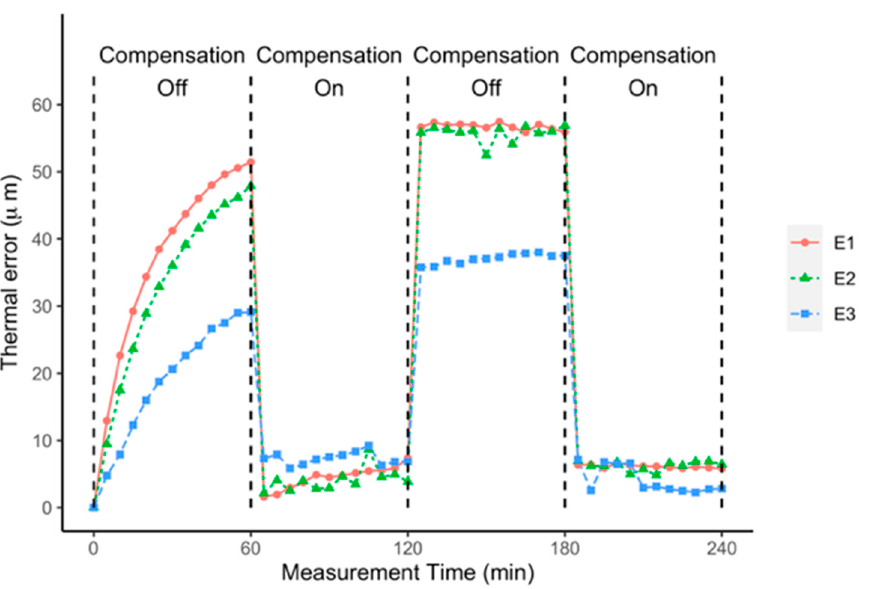
Figure 12. Thermal error measurements in the Z direction when the compensation function is turned off and on.